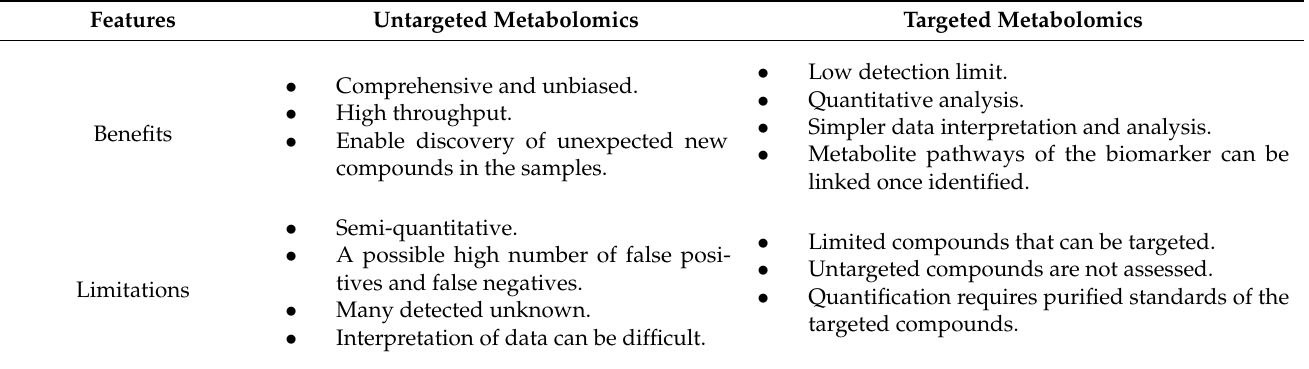
Table 2. Comparison of benefits and limitations of untargeted and targeted metabolomics [23–27].